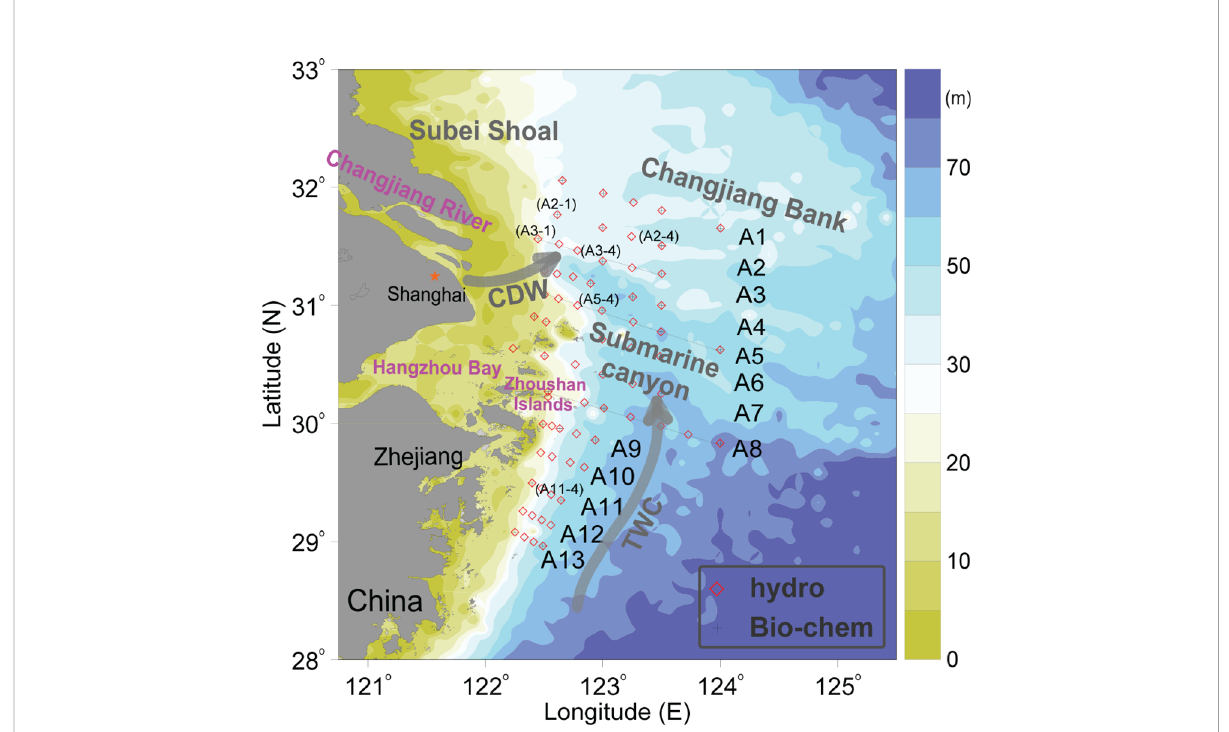
FIGURE 1 Geographic map of the study area and its adjacent region, which shows the station locations in August 2013 and associated currents. CDW and TWC represent the Changjiang Diluted Water and Taiwan Warm Current,